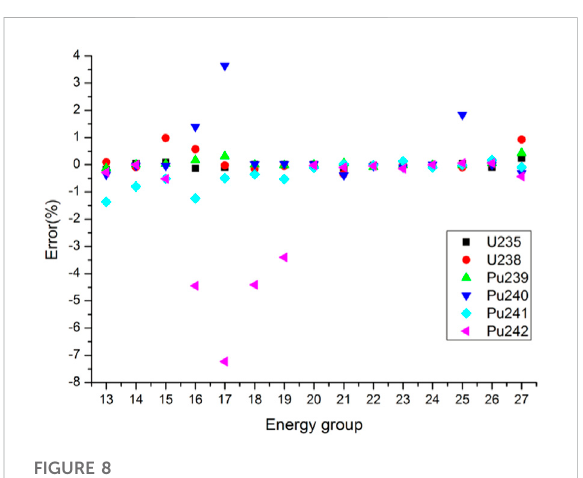
FIGURE 8 Comparison of resonant nuclides ’ absorption cross sections in 8 wt% PuO 2 .